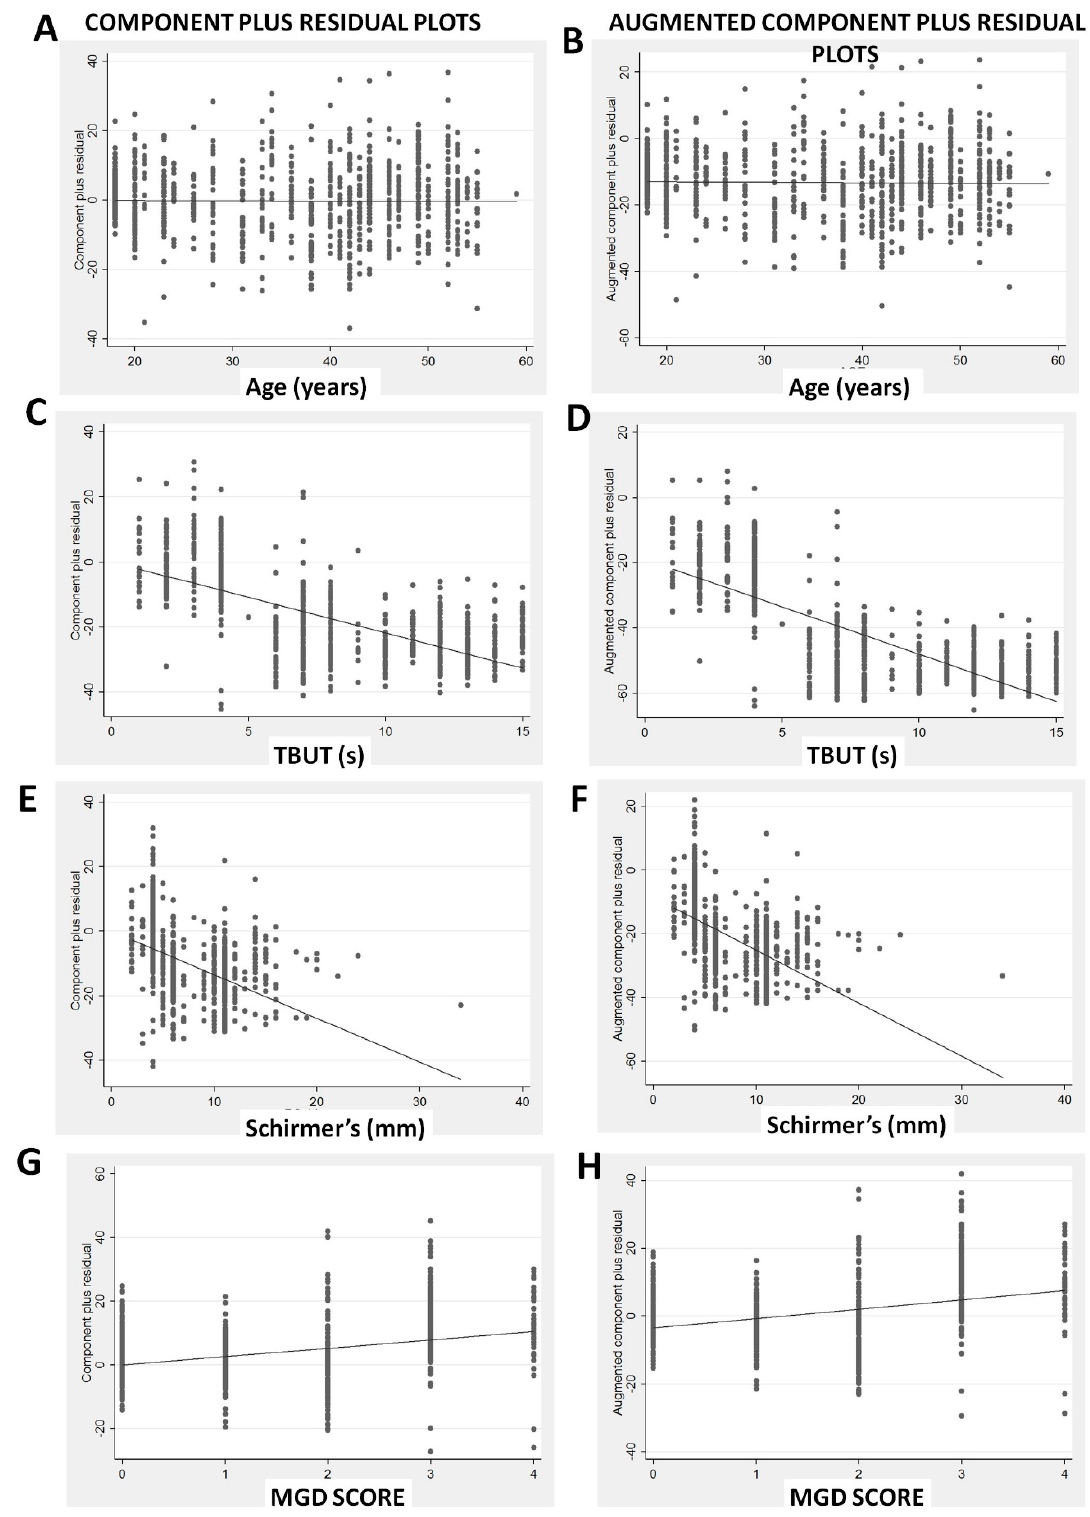
Figure 5. Graphs showing the component plus residual plots ( A , C , E , G ) and the augmented component plus residual plots ( B , D , F , H ). plus residual plots ( B , D , F , H